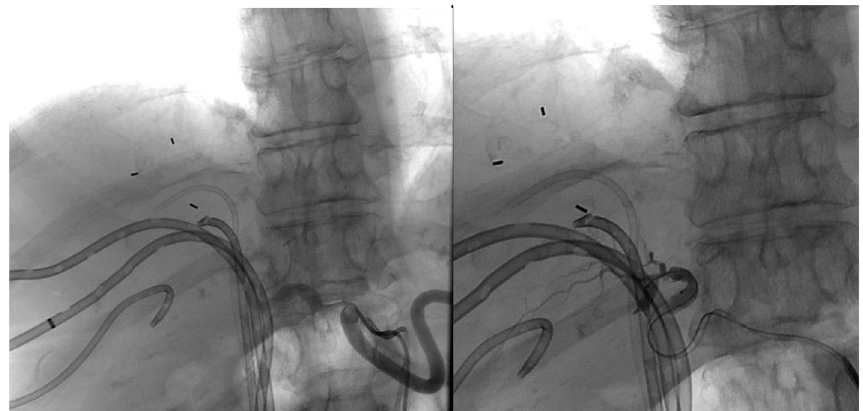
Fig. 3 a , b Variation of DBT using two Simmons 1 catheters. a This patient had a stenotic and downward going celiac axis that would not allow for the destination sheath to track, so via bilateral common femoral access two 5F Simmons 1 catheters were used to select the celiac axis (black and white arrow heads). b Through each of these 5F catheters the 2.1 French sniper catheters were positioned, balloons inflated (green arrows), and the lesion was